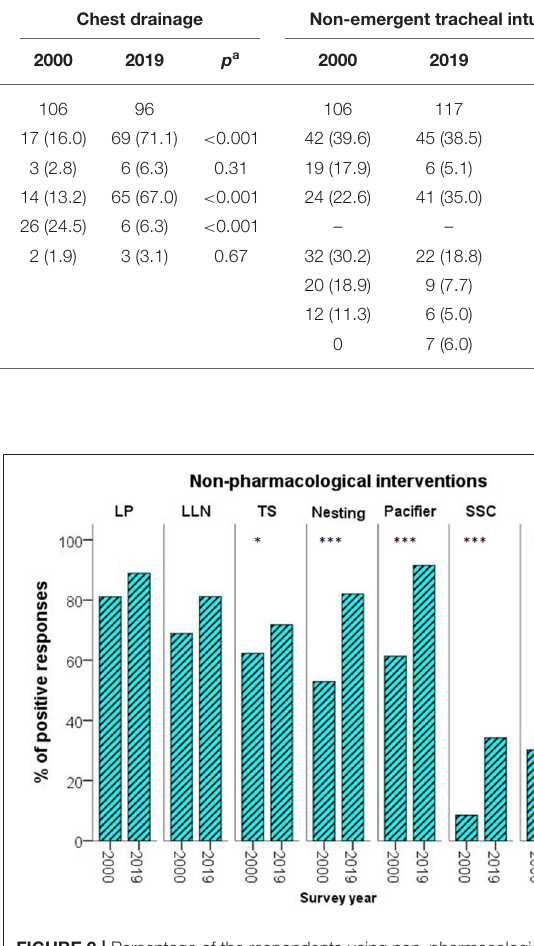
the number of procedures and applied tactile stimulation at both time-points ( Figure 2 ).